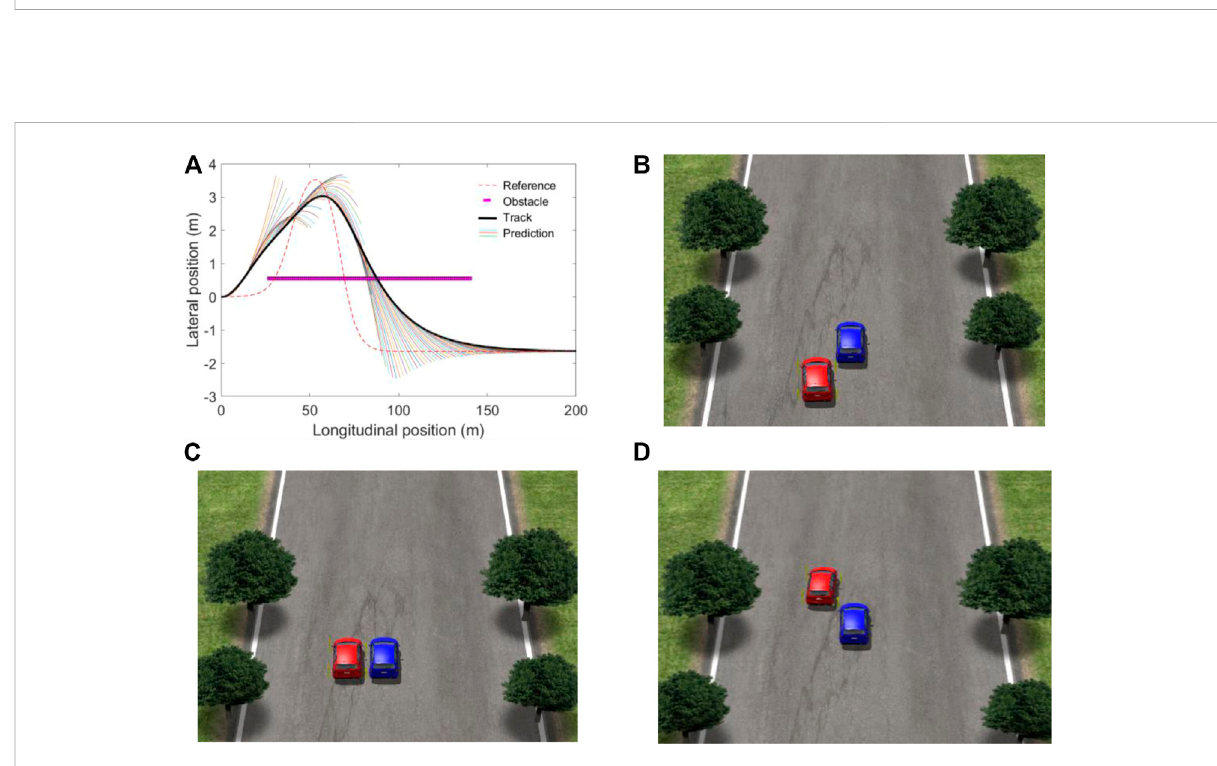
FIGURE 8 Obstacle avoidance trajectory and obstacle avoidance model at 72 km/h. (A) obstacle avoidance trajectory; (B) model before obstacle avoidance; (C) model during obstacle avoidance; (D) model after obstacle